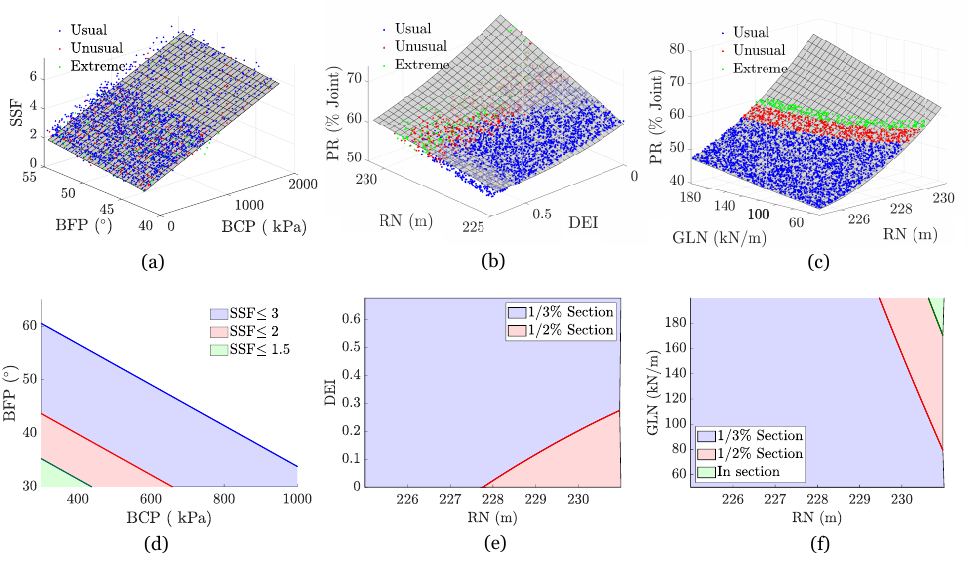
Figure 13. Stability analysis output: ( a ) SSF-Base, ( b ) PR-Base, ( c ) PR-Crest, ( d ) BCP-BFP regions, ( e ) RN-drain efficiency (DEI) regions and ( f ) RN-GLN